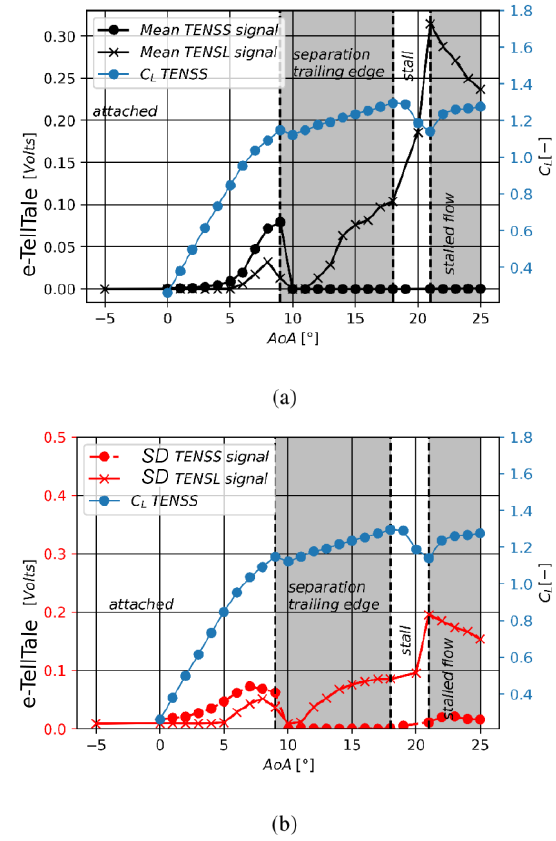
Figure 11. Comparison of the mean (a) and the standard devia- tion (b) of the signal of the TENSL (reference case) and TENSS e-TellTale sensors as a function of AoA.